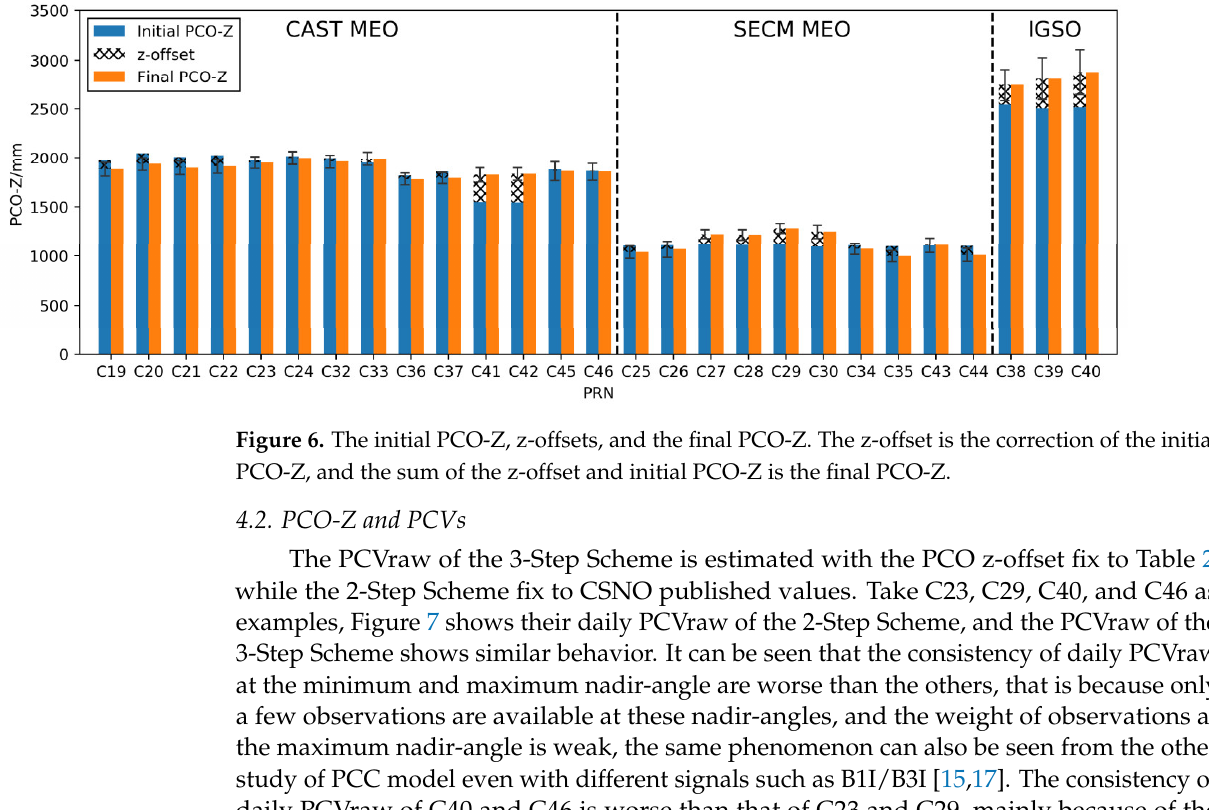
9 of 17 Figure 5. The structure of BDS-3 IGSO satellites (http://www.csno-tarc.cn/en/system/introduction (accessed on 7 November 2022)). Table 2. Final satellite-specific PCO z-offset, the unit is mm. PRN